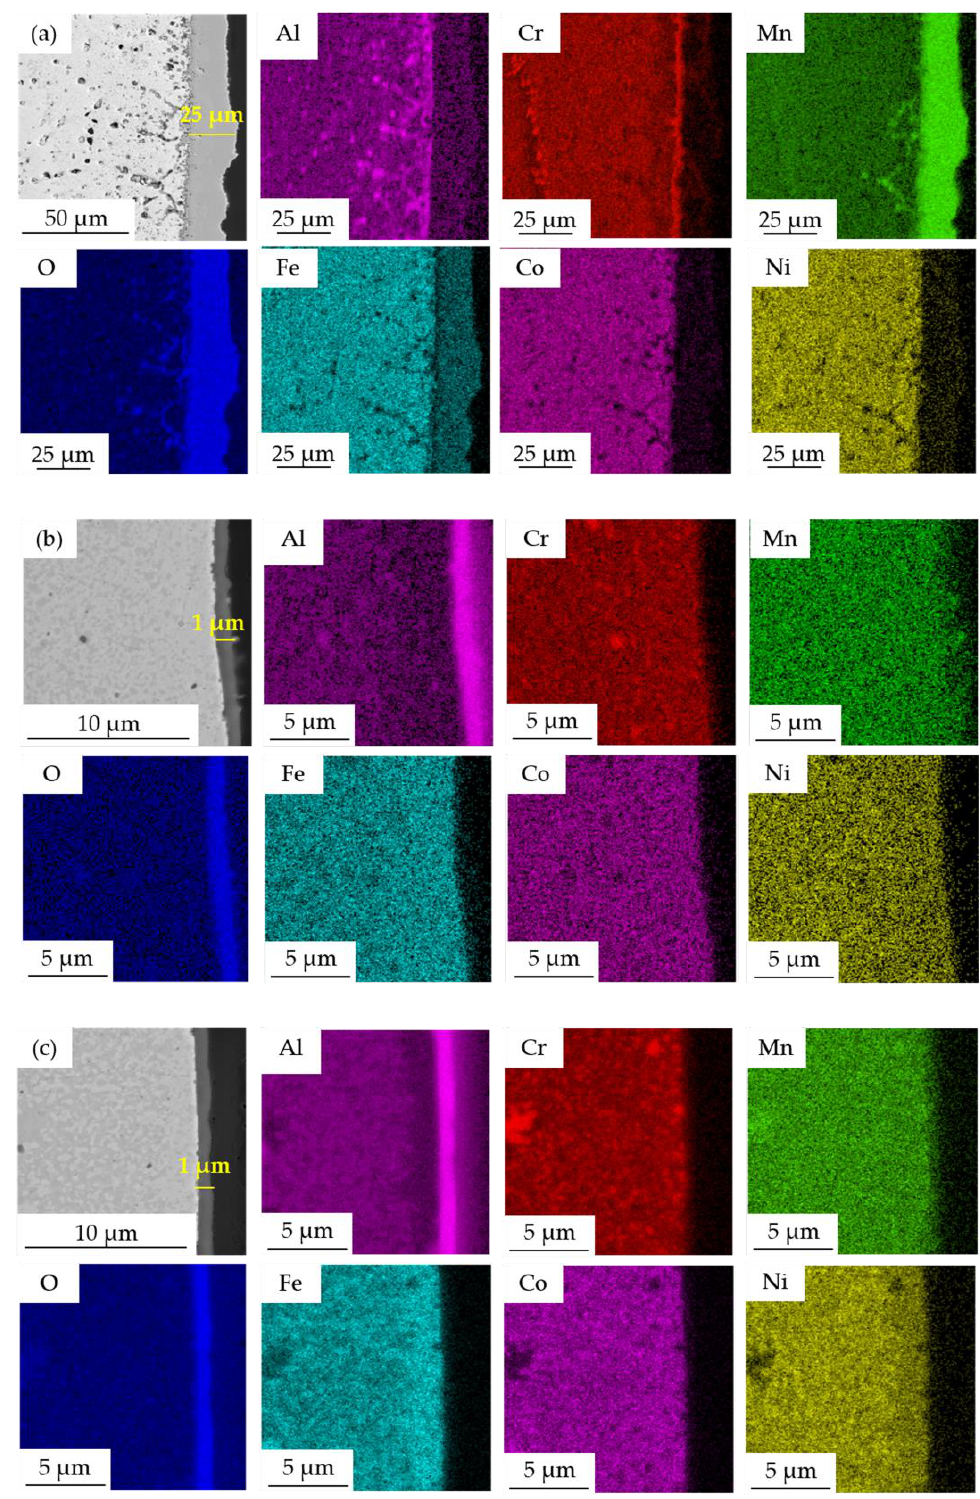
Figure 15. SEM + EDS element distribution maps across the oxide layers formed after 100 h annealing at 800 °C: ( a ) Mn15Al5, ( b ) Mn10Al10, ( c ) Mn5Al15.